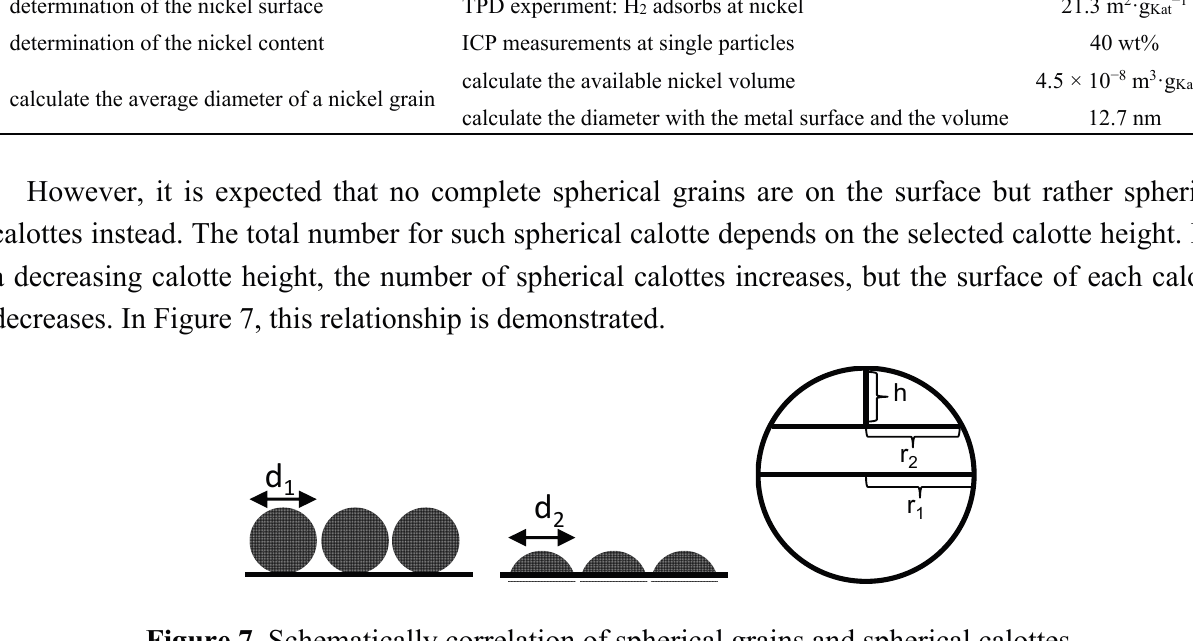
Figure 7. Schematically correlation of spherical grains and spherical